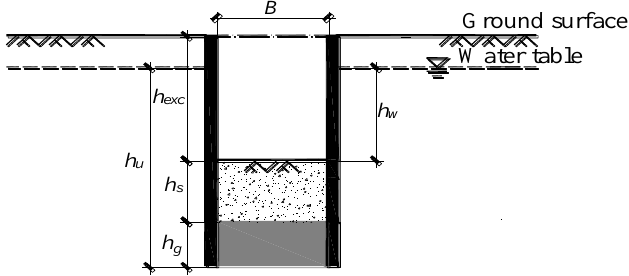
Figure 1. Plan view of jet-grouted bottom sealing barriers.